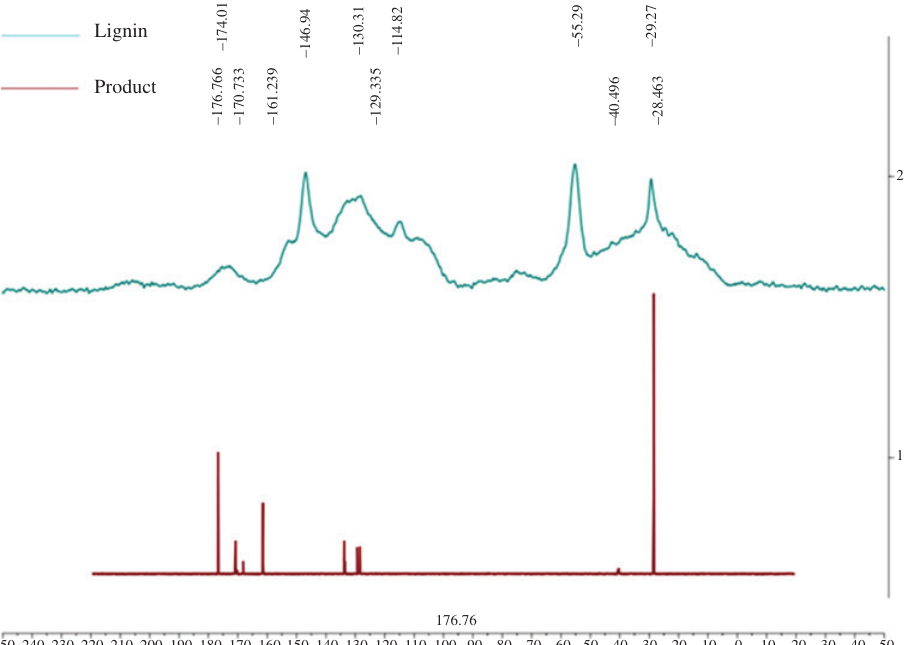
Figure 7: 13 C NMR spectra of lignin solid and the liquid degradation product catalyzed by the CuFeS